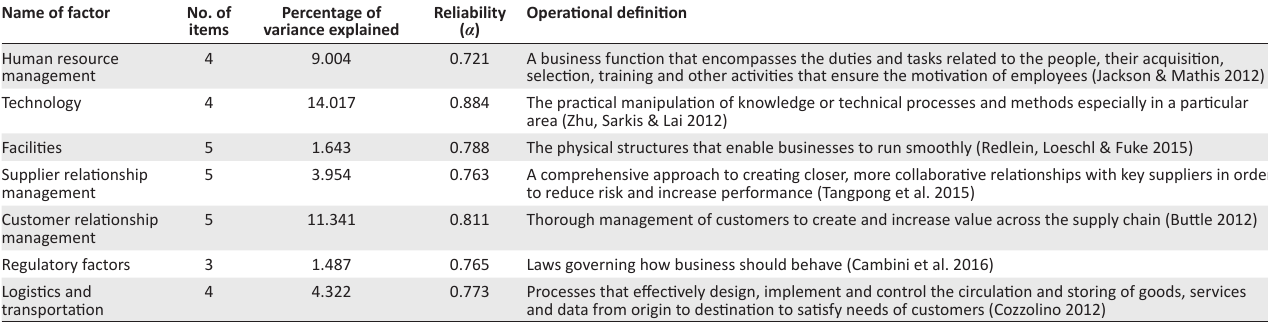
TABLE 1: Extracted constructs and operational